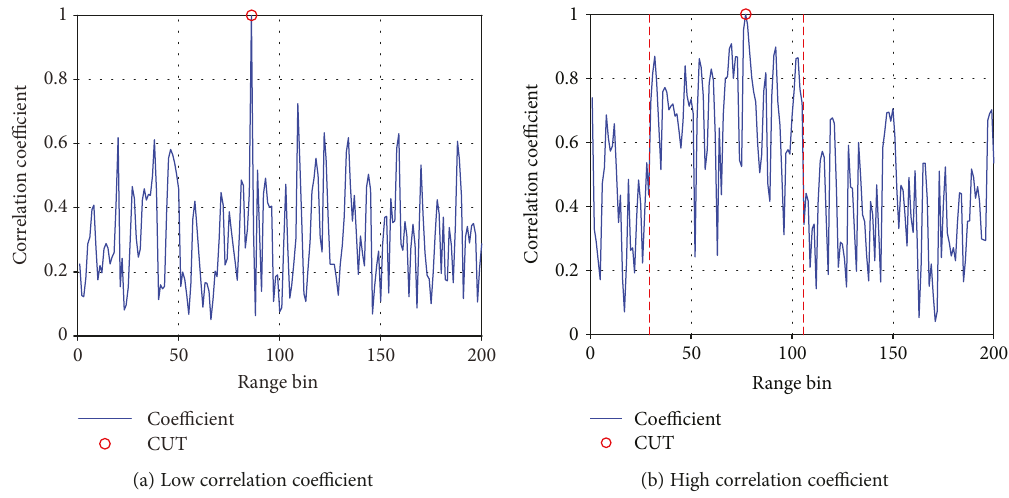
Figure 4: Range correlation coe ffi cients in di ff erent situations.